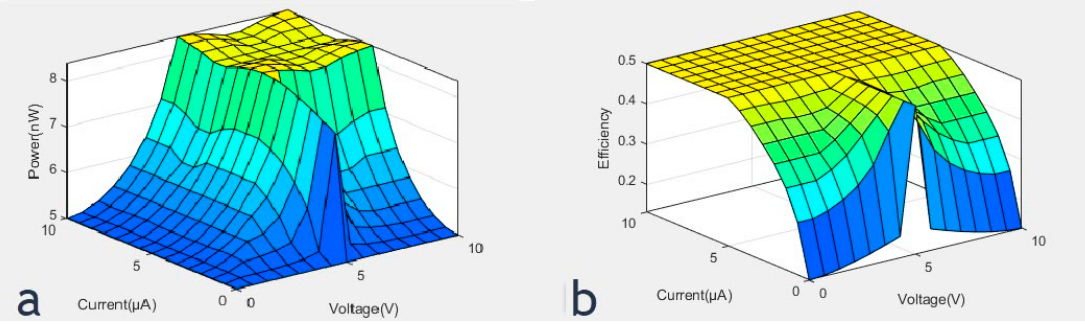
Figure 8. 3D graphs for EHFLC.